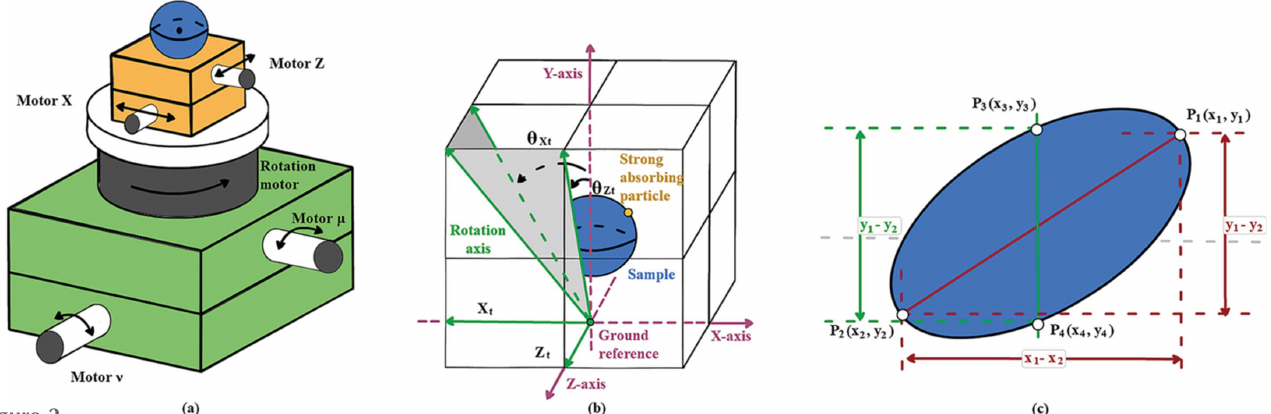
Figure 2 ( a ) Sample positioning stage. Motor x and motor z control the movement of the sample, the rotation motor controls the rotation of the sample, and motor (cid:3) and motor (cid:4) control the tilt of the rotation axis. ( b ) Rotary-axis tilt model. The tilt angle of the axis of rotation can be split into the superposition of two orthogonal vectors. ( c ) Physical model of the rotary axis coarse alignment. The adjustment angle of the axis of rotation is roughly calculated from the coordinates of the four feature